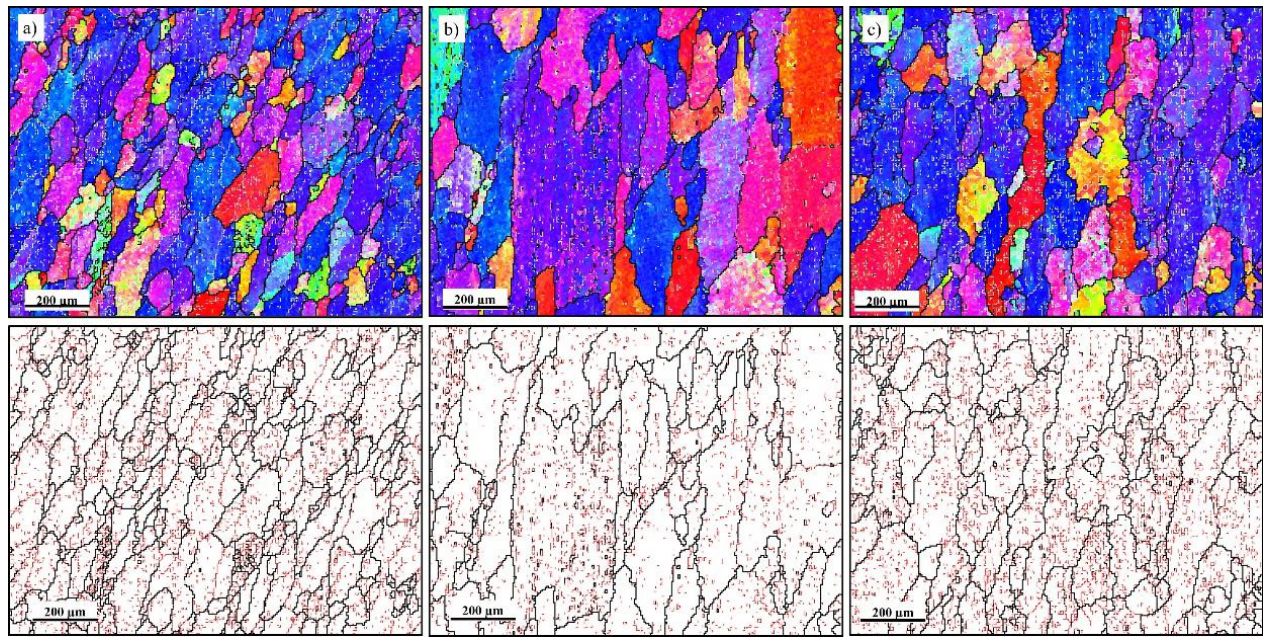
Figure 14. IPF maps and their corresponding GB maps of the 1- p ECAP processed AA2011 ( a ) left edge, ( b ) center, ( c ) right edge.